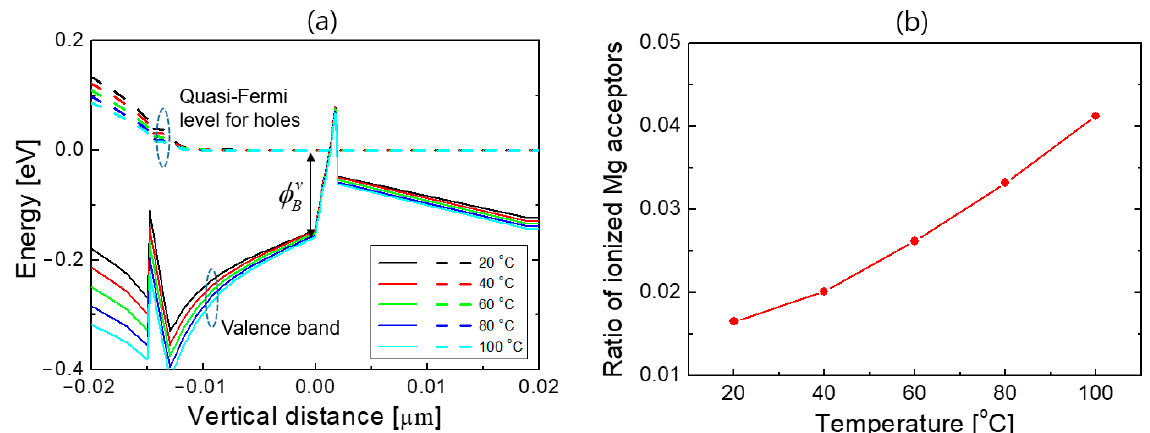
Figure 7. ( a ) Valence band diagrams at 20, 40, 60, and 80 °C when the injection current is 350 mA. The solid and dotted lines indicate the valence band edge and hole quasi-Fermi energy level, respectively. The origin of the horizontal axis corresponds to the position of the maximum effective potential barrier height. φ v represents the difference between the valence band edge and the hole quasi-Fermi energy level at the origin. ( b ) Ratio of ionized Mg acceptors as a function of temperature.